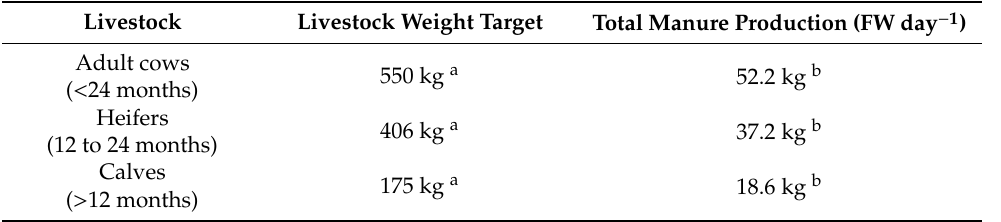
Table 1. Characteristics of dairy